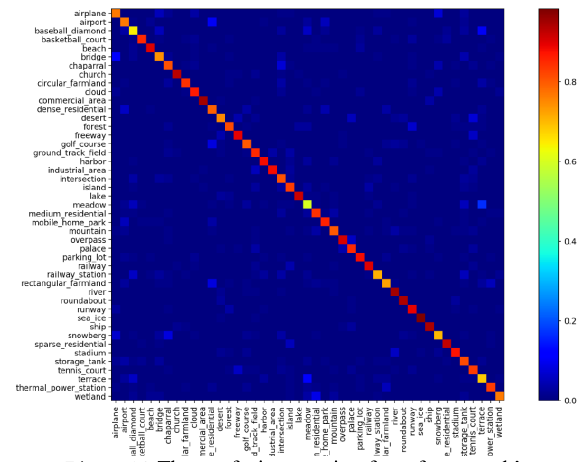
Figure 12 The confusion matrix of our framework’s performance on NWPU-RESISC45 dataset.